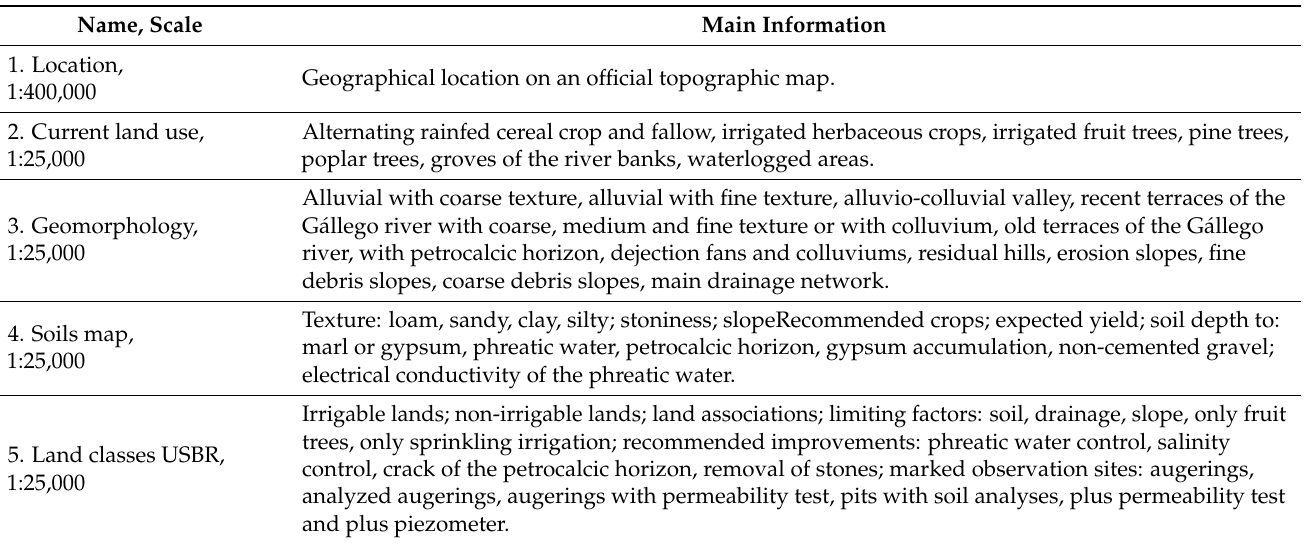
Table 4. Plans contained in the IRYDA report [1] with their scale and main